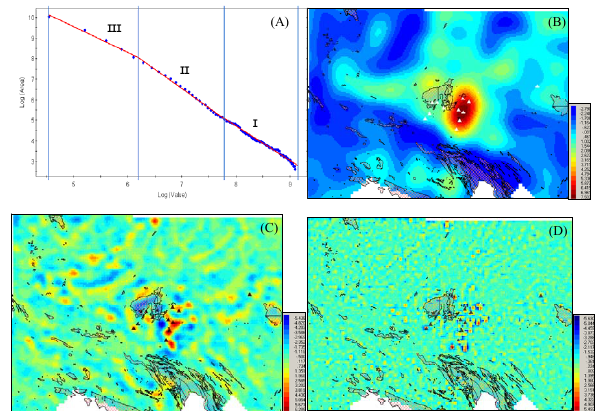
Fig. 5. (A) Plot showing the S-A relationship between the spectral energy density (S) and area (A). The dots are the calculated results and the three red lines labeled as I, II, and III were fitted by the LS method. The logarithmic transformations are base ten. (B) –(D) Decomposed background, anomalous and noise components of As using filters I, II and III, respectively. The black polygons are mapped intrusions. The black triangles are tin mineral deposits.